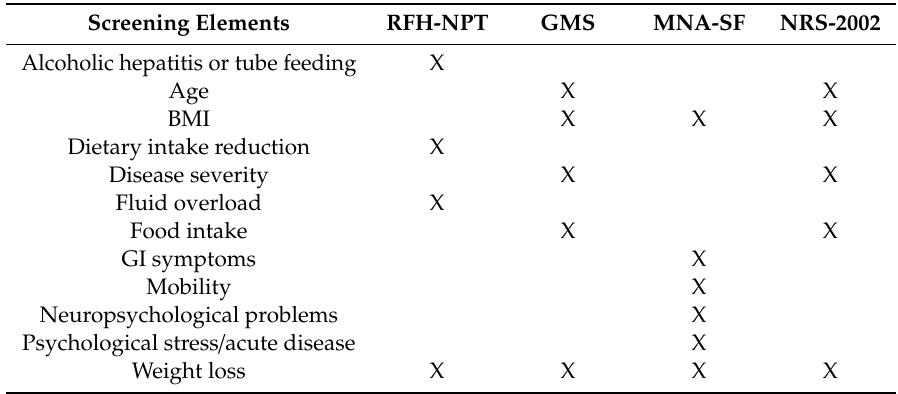
Table 1. Summary of screening elements used in the nutrition screening tools. Screening